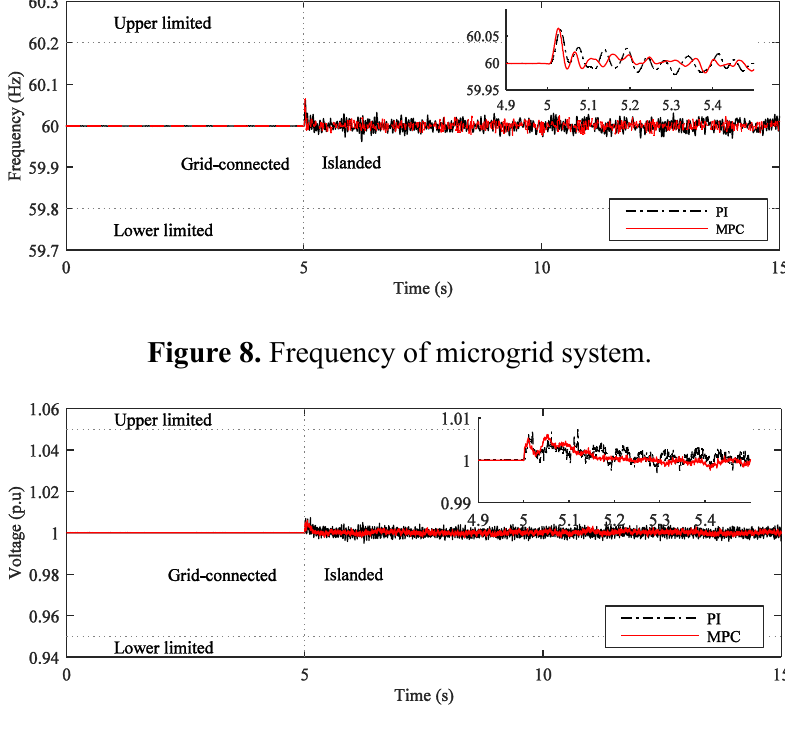
Figure 9. Voltage of microgrid